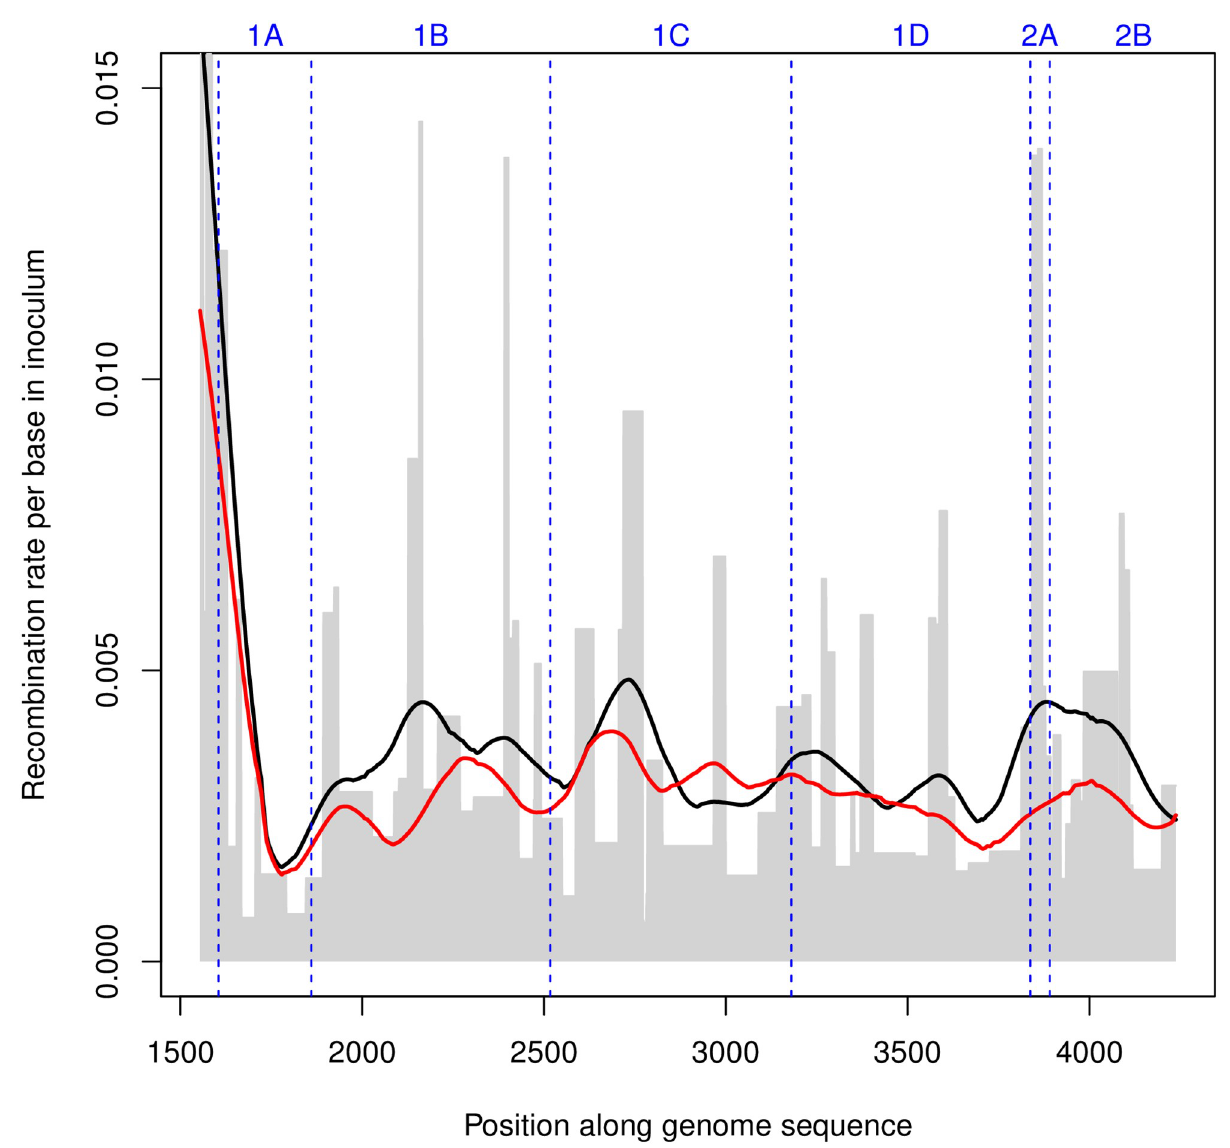
Fig 5. Effective cumulative recombination rate per base for the inoculum (in grey), inferred by the “local” approach from pairs of SNPs covered by at least 10 3 reads. The lines indicate the average local rates (black) and global rates (red) Gaussian-smoothed over a 150 bases window.